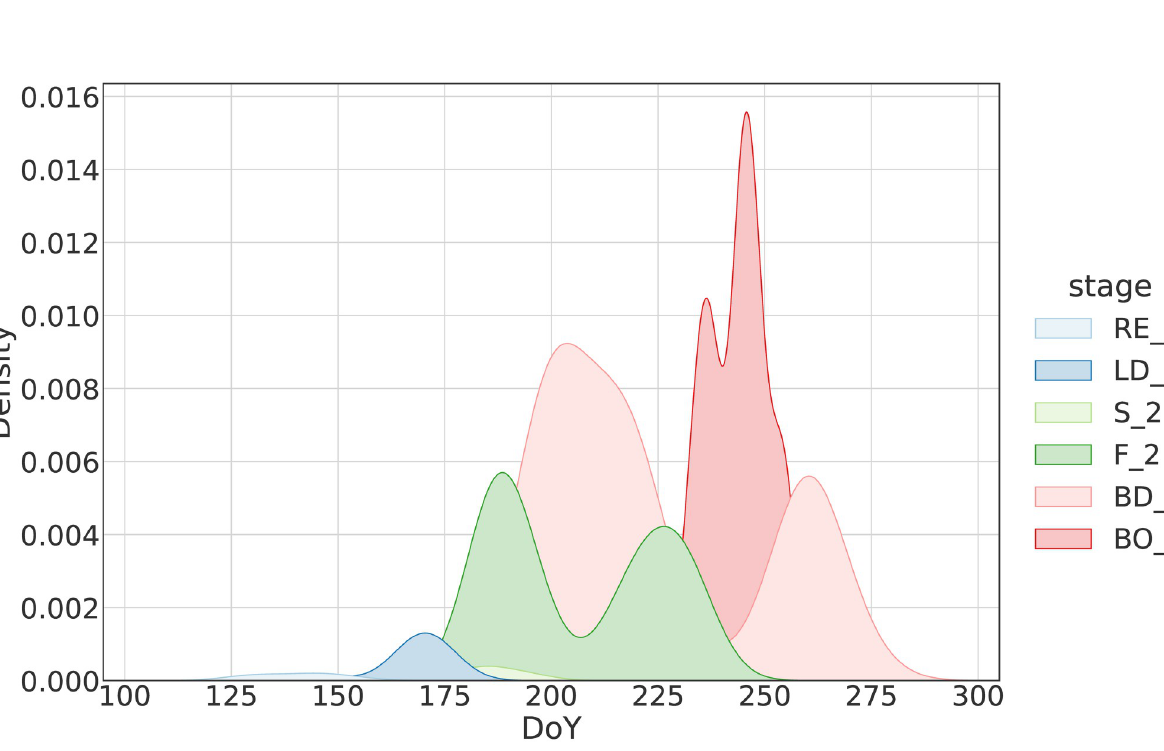
PLOS ONE | https://doi.org/10.1371/journal.pone.0282364 March 8,